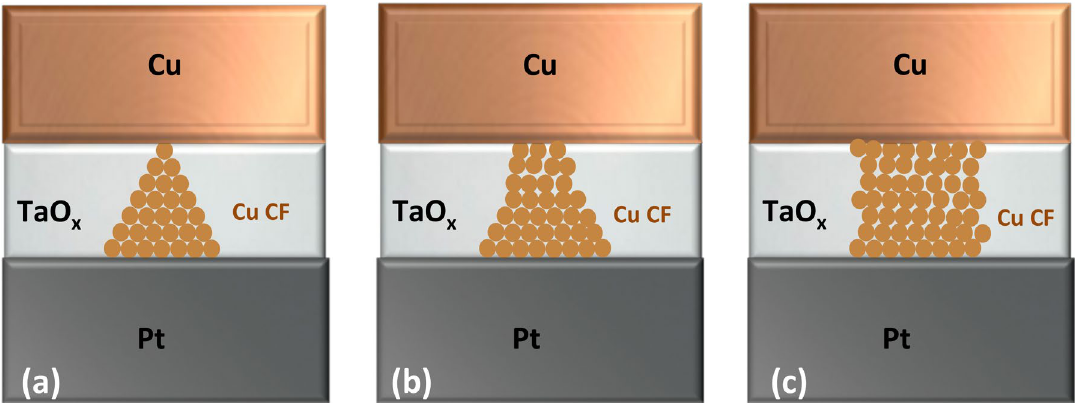
Figure 4. Model geometry for Cu conductive filaments (and also nanocontacts) formed at various I cc levels. ( a ) Filament formed at low I cc resulting in a single atom contact. ( b ) Filament formed at moderate I cc resulting in few atom contact. ( c ) Filament at a high I cc resulting in a cylindrically-shaped filament with mesoscopic contacts with both